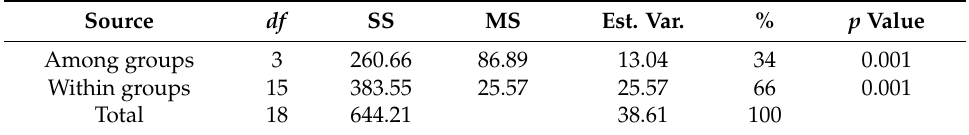
Table 6. Differentiation among and within four groups of mutant genotypes by AMOVA. Source df SS MS Est. Var. % p Value Among groups 3 260.66